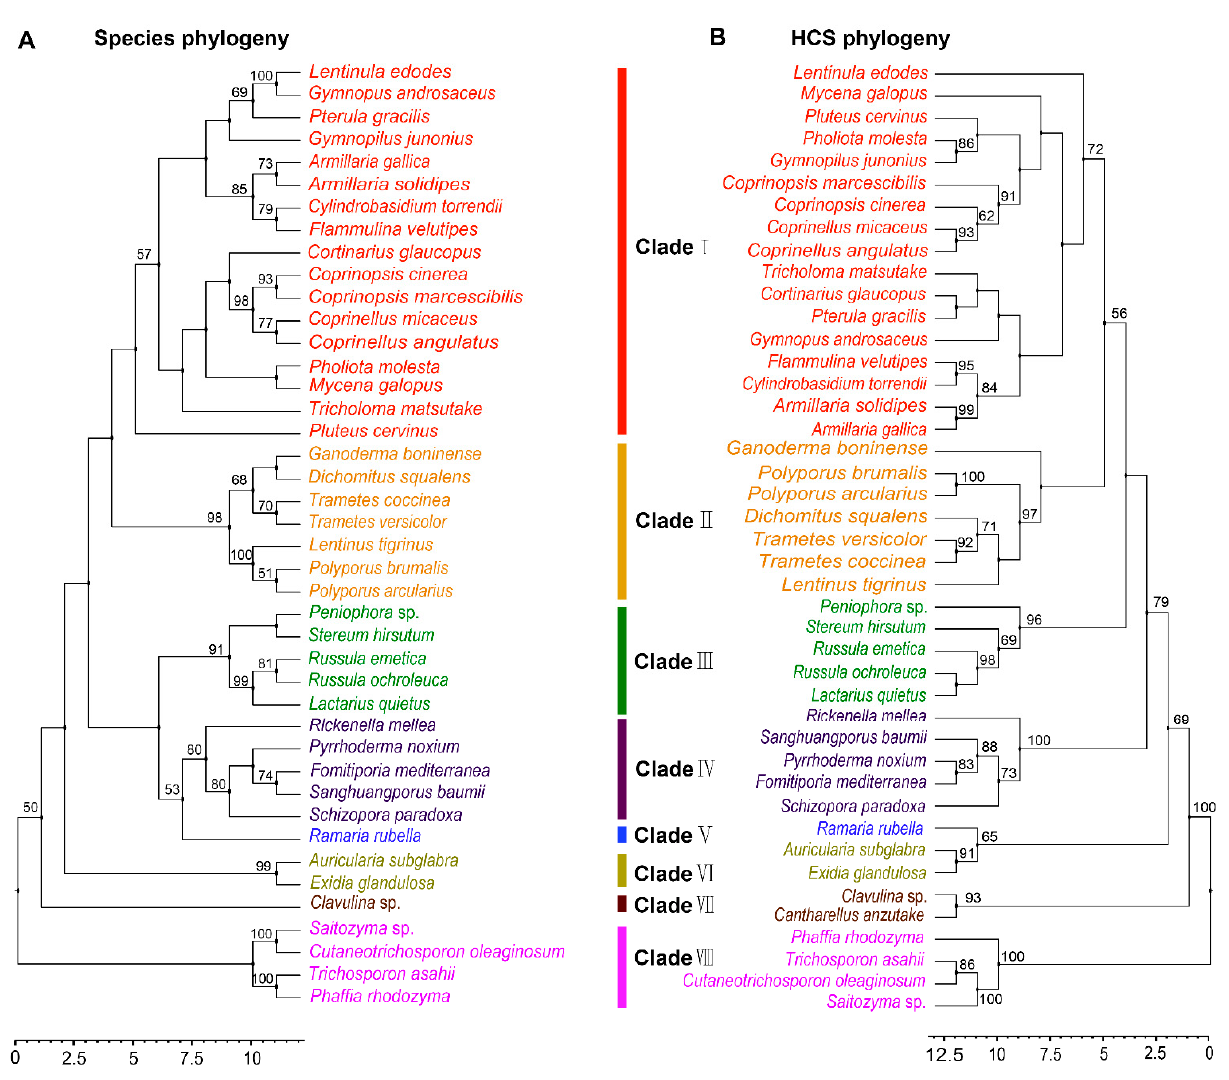
Figure 2. Phylogenetic relationship of both species and HCS homologous sequences in Agaricomycetes. ( A ) Maximum likelihood tree showing the relationships among different orders of Agaricomycetes based on LSU, SSU, RPB1, RPB2, ITS (5.8S), and EF1- α genes with species in Tremellomycetes as the outgroup. ( B ) Maximum likelihood tree showing the relationships among different orders of Agaricomycetes based on HCS amino acid sequences with species in Tremellomycetes as the outgroup. MP bootstrap values ( ≥ 50%) of each clade are indicated at nodes. Scale bar in the upper left indicates substitutions per site. (Clade I: Agaricales, Clade II: Polyporales, Clade III: Russulales, Clade IV: Hymenochaetales, Clade V: Gomphales, Clade VI: Auriculariales, Clade VII: Cantharellals, and Clade VIII: Tremellomycetes).